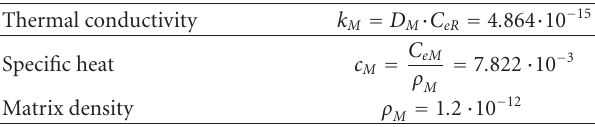
Table 1: Material properties associated with the bundle RUC used for the analogy.